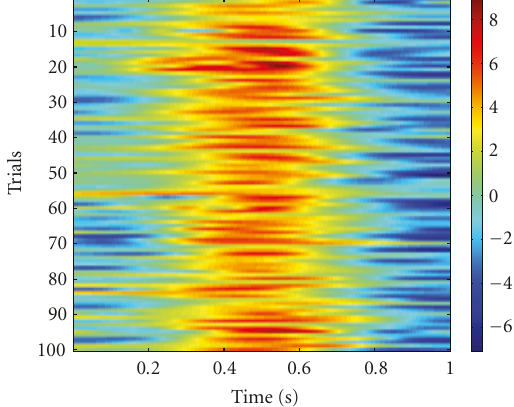
Figure 5: ERP image of ensemble of EMD-denoised single trials.